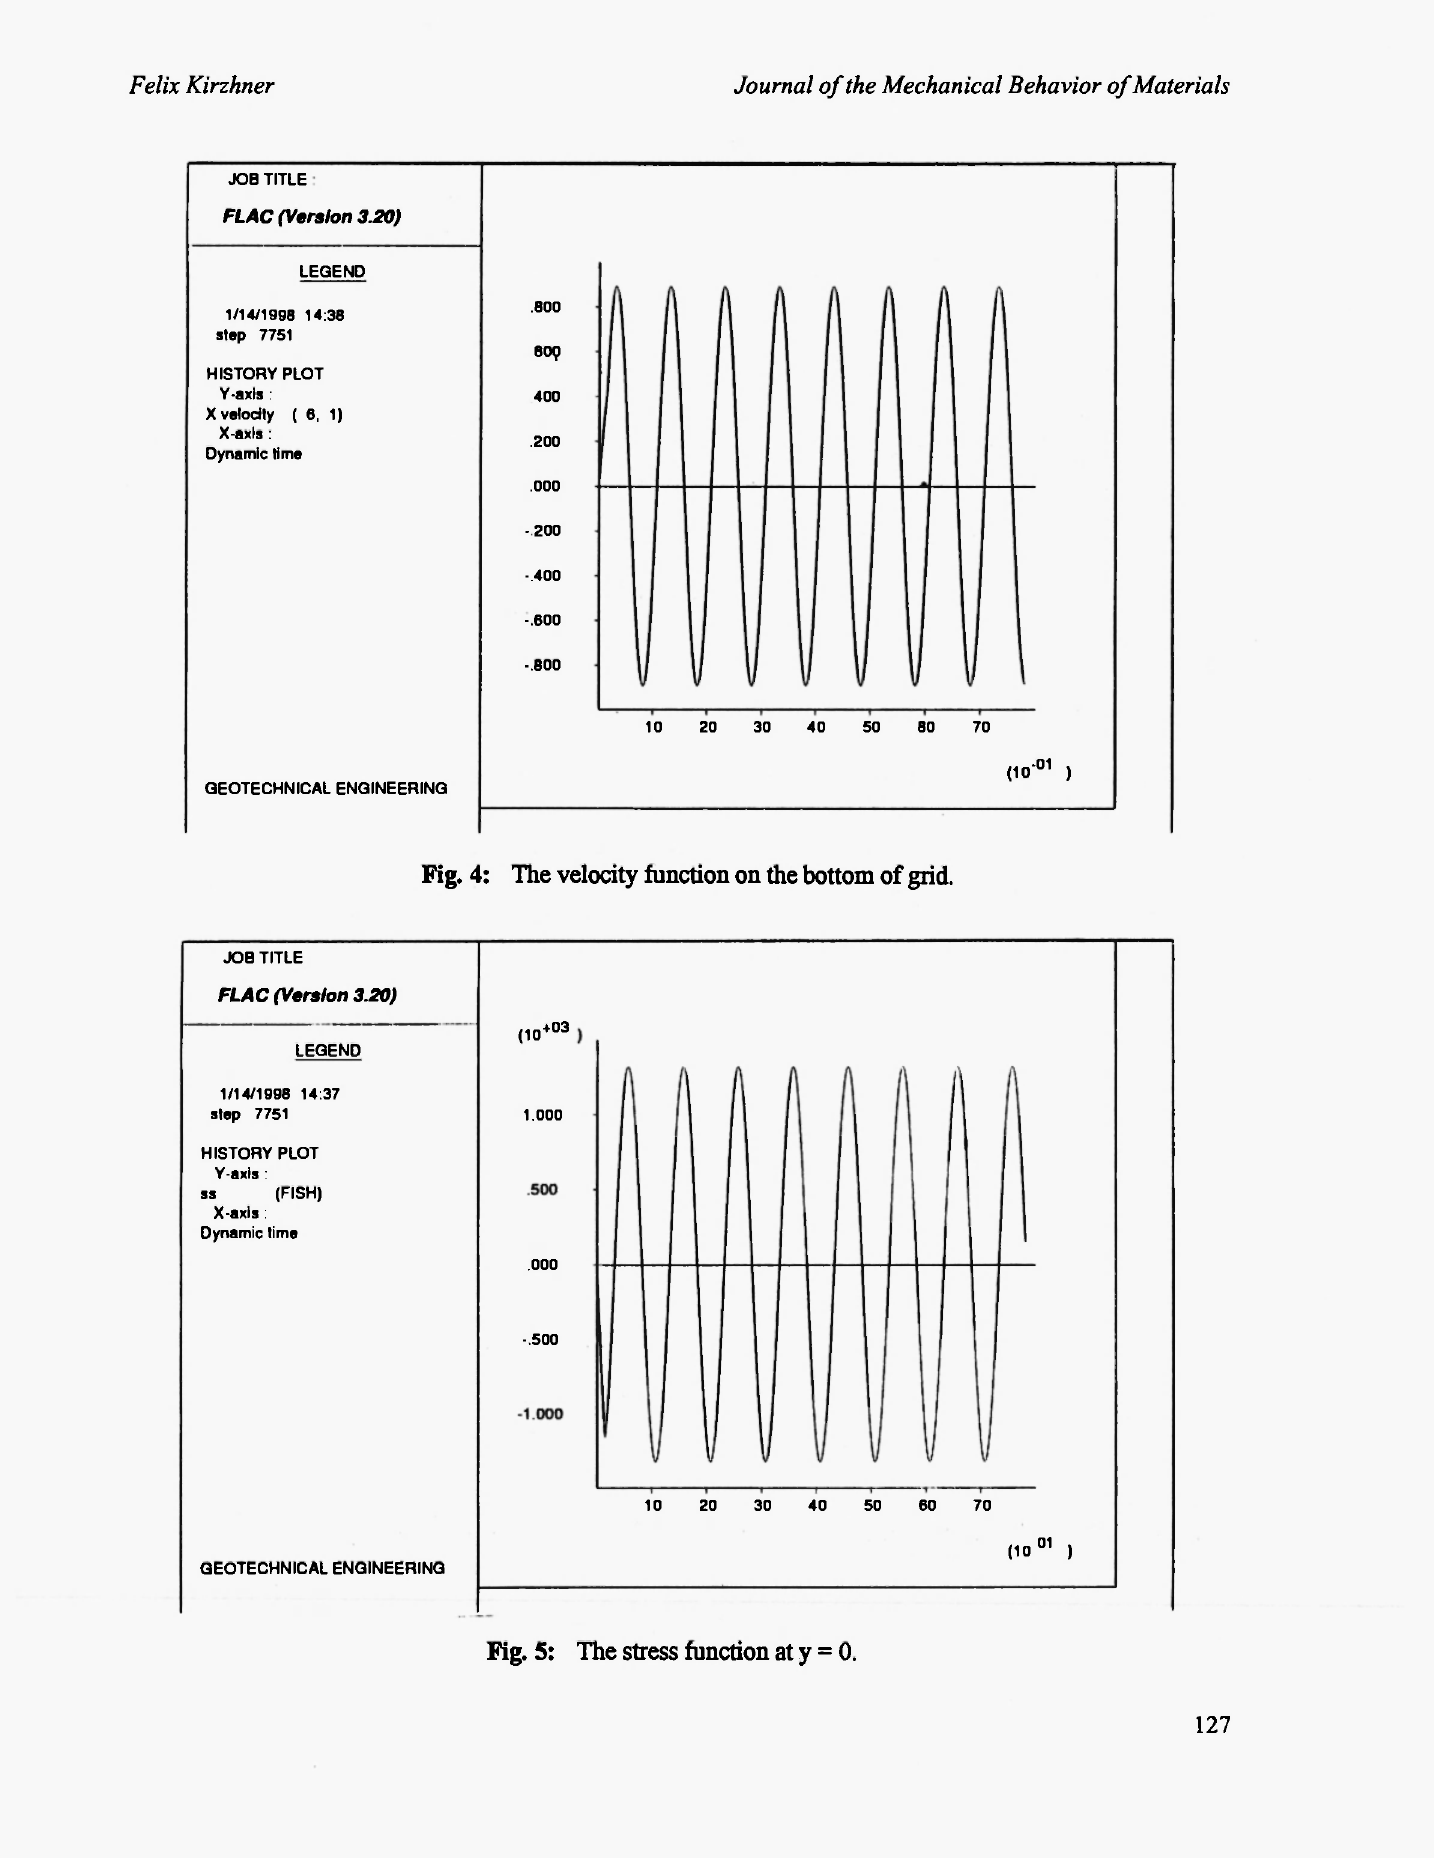
Fig. 4: The velocity function on the bottom of grid.